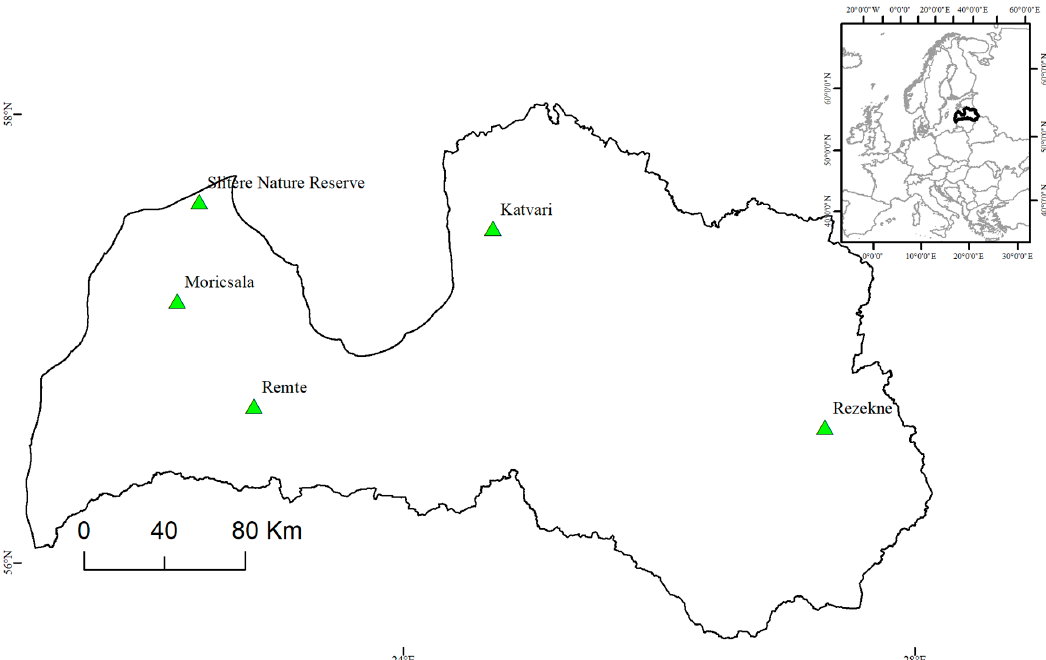
Figure 1. Location of selected Norway spruce populations) .